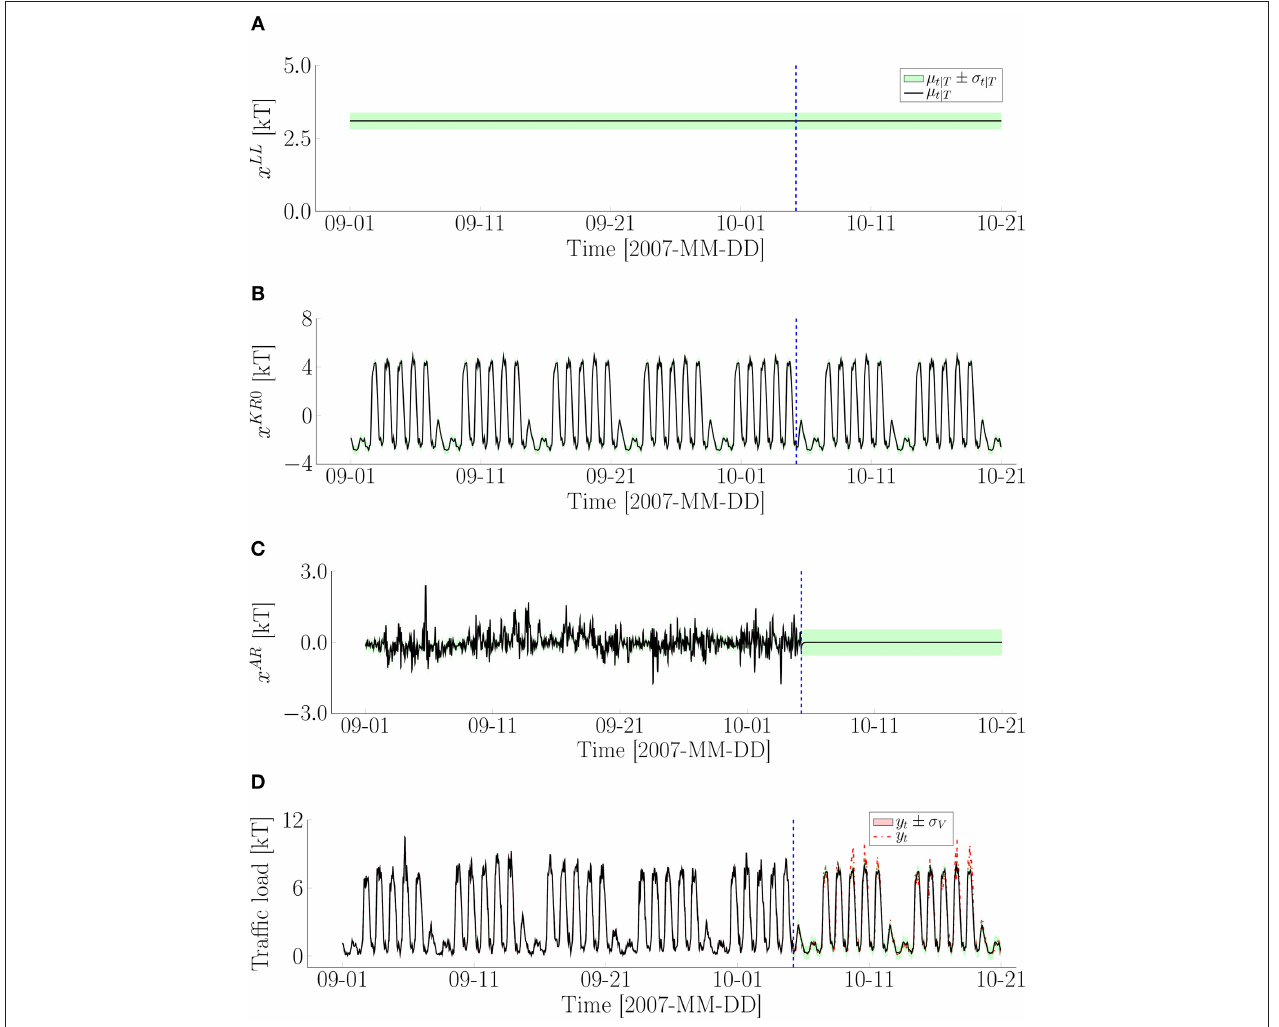
FIGURE 7 | Illustration of the estimation of hidden state variables for the traffic load data: (A) Baseline component, x B t ; (B) Hidden predicted pattern, x KR t ,0 ; (C) Autoregressive component, x AR t ; (D) Traffic